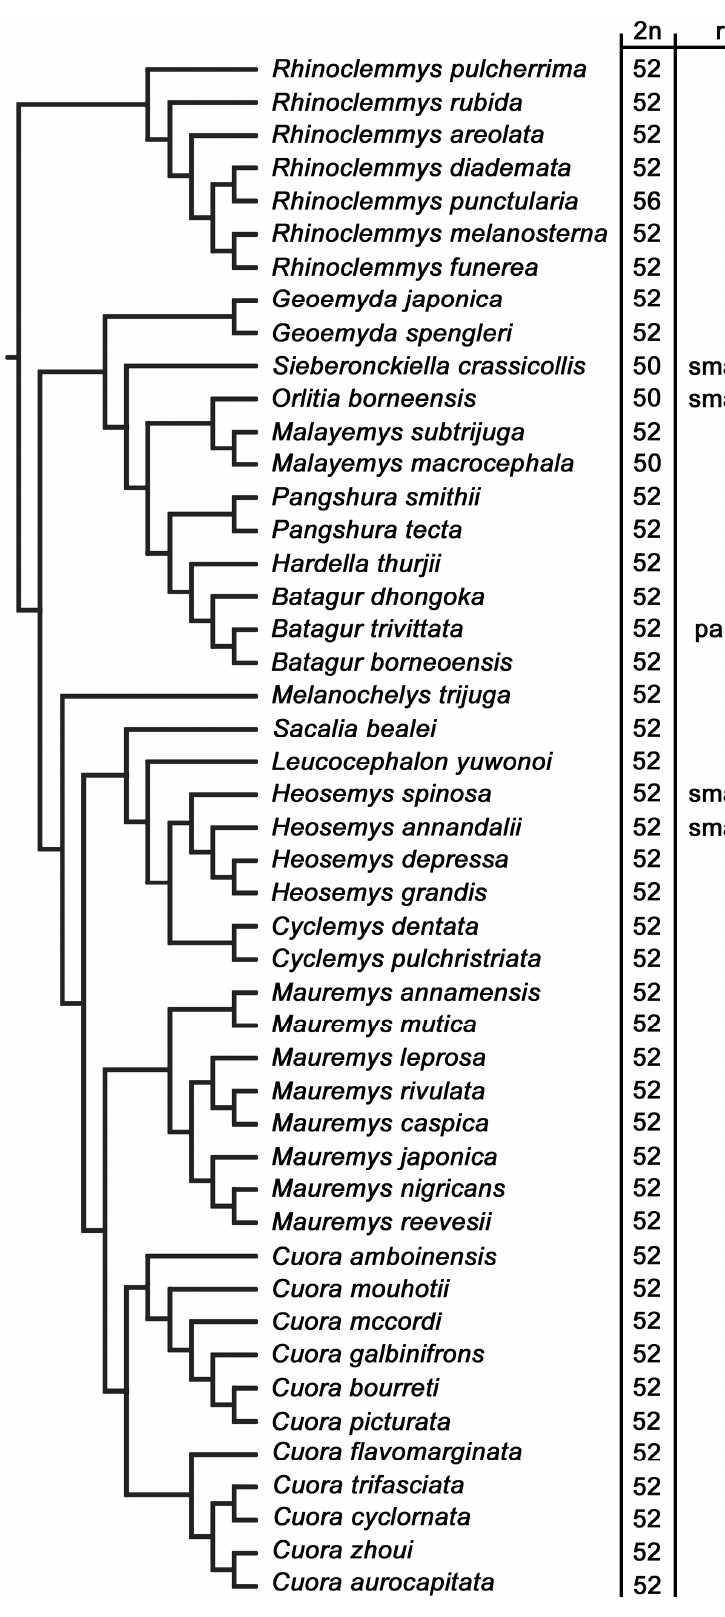
Figure 5. Distribution of diploid chromosome numbers and topology of rDNA loci and TTAGGG telomeric repeats across the phylogeny of geoemydid species. Phylogenetic branching patterns from Colston et al. [30].